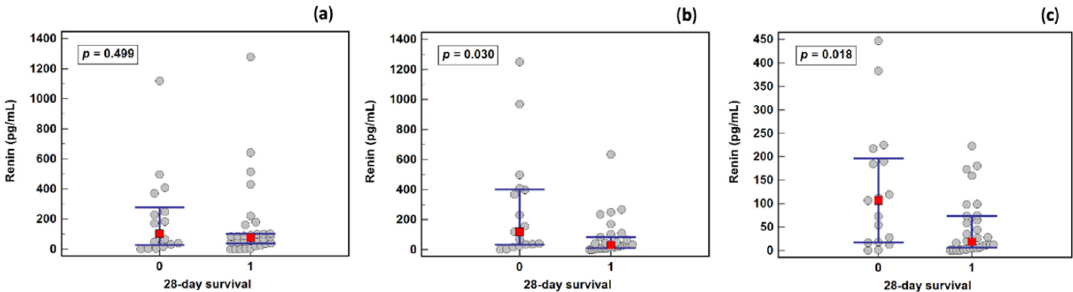
Figure 6. Renin concentration in sepsis survivors and non-survivors: ( a ) on the first study day; ( b ) the third study day; ( c ) in the fifth study day. Legend: 0—non-survivors, 1—survivors. Notes: Data were analyzed using Mann–Whitney U tests, and are presented as medians (red squares) with interquartile ranges (blue whiskers).